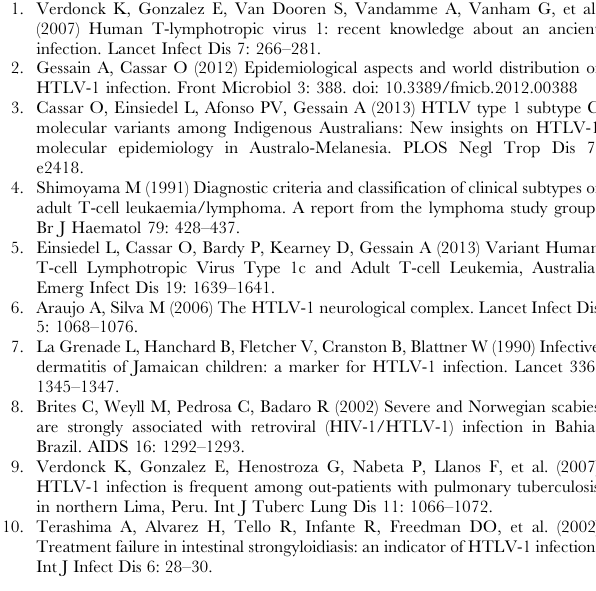
Table S1 Disease categories and their ICD-10 AM codes recorded 2005–2010. International classification of diseases 10